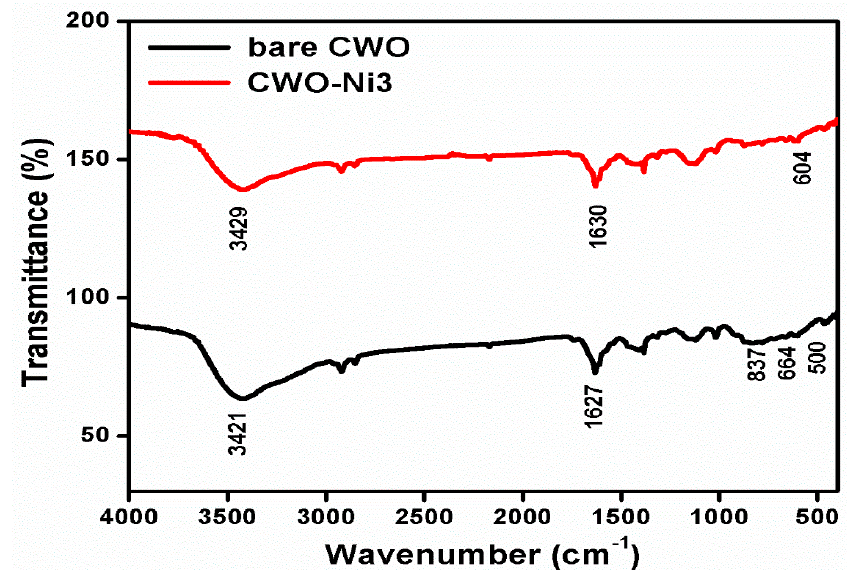
Figure 2. Fourier transform infrared (FT-IR) spectra of bare CWO and CWO–Ni3.